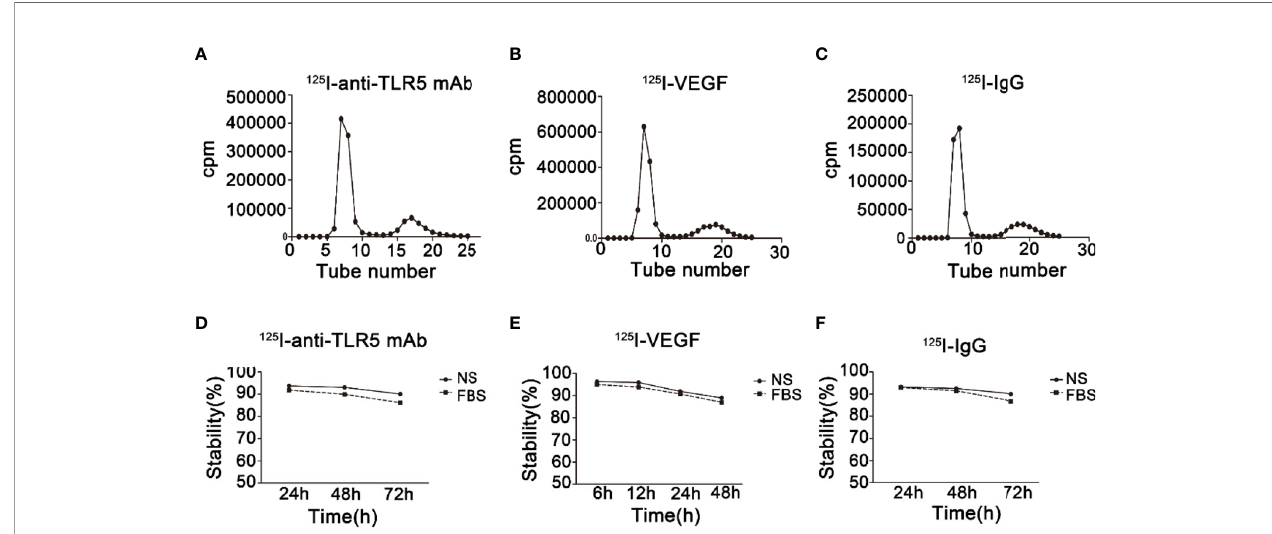
FIGURE 2 | Radiochemical purity and stability of radio-probes. Radiochemical purity of 125 I-anti-TLR5 mAb/ 125 I-VEGF/ 125 I-IgG (A – C) . Stability of 125 I-anti-TLR5 mAb/ 125 I-VEGF/ 125 I-IgG in saline and serum at different time points (D – F) .